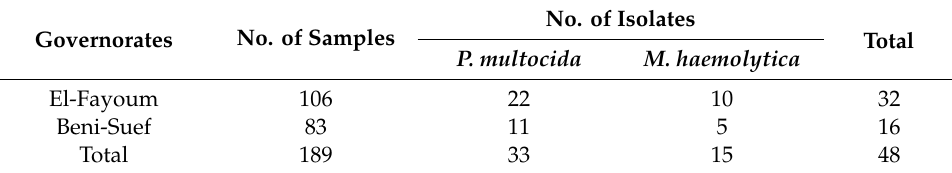
Table 1. Samples and bacterial isolates in di ff erent